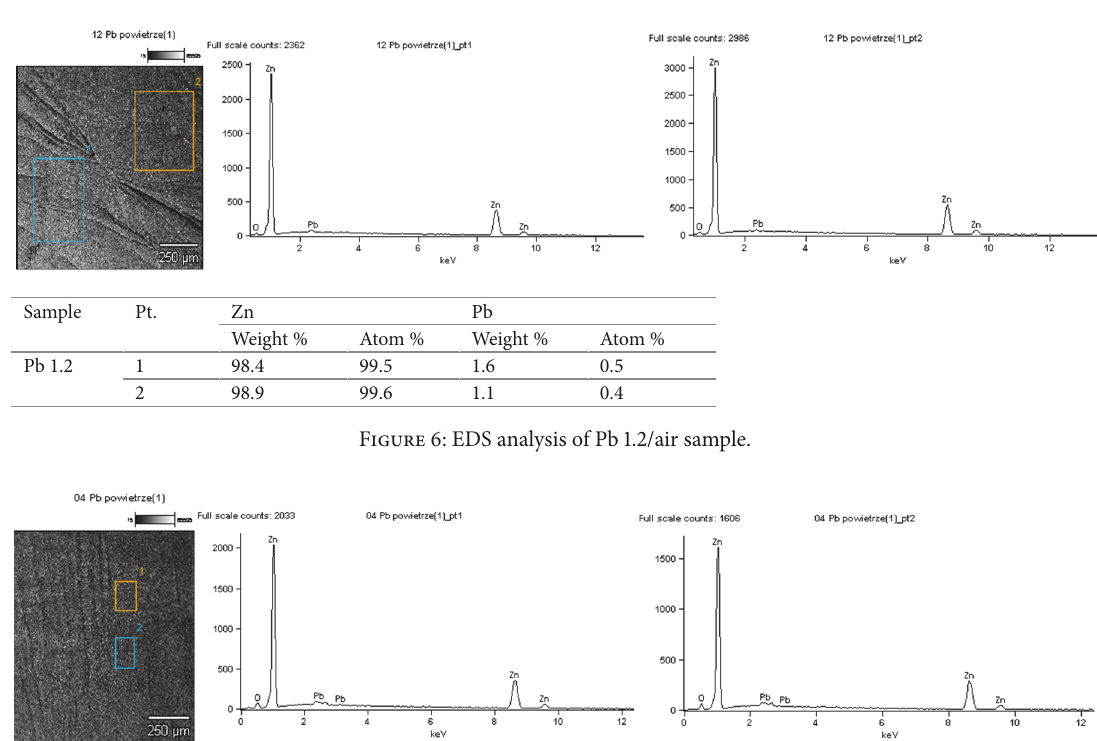
Figure 5: EDS analysis of Pb 1.2/water sample at point 1.